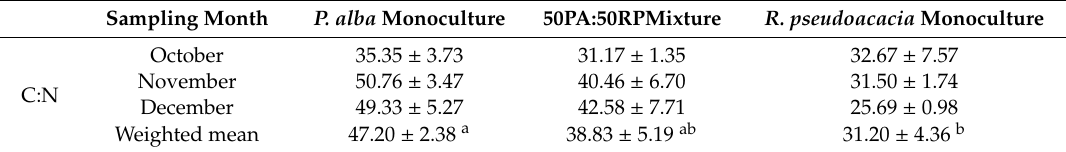
Table 4. Average values ± standard deviation of C:N ratio in the three months of leaf litter harvesting for the plots